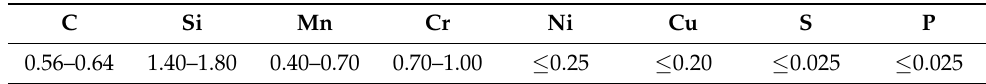
Table 1. The chemical composition of 60Si2Cr, %